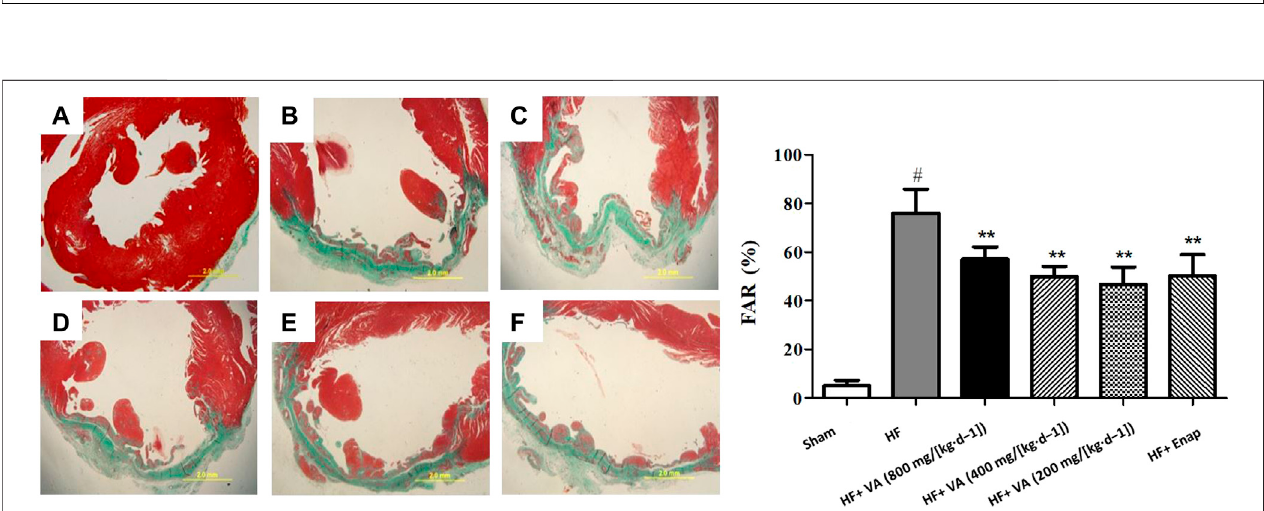
FIGURE 4| The effect of velvet antlers (VA) on myocardial collagen deposition. (A) Representative myocardialtissueof the sham group (a) , heart failure(HF) group (b) ,HF+lowdoseofVAgroup (c) ,HF+mediumdoseofVAgroup (d) ,HF+highdoseofVAgroup (e) ,andHF+enalaprilgroup (f) stainedwithMasson ’ strichrome.Bar (cid:1) 20 mm. (B) Statisticalanalysisofthe fi broticarearatio(FAR)ineachgroup.Thedataareexpressedasmeans ± SEM.#: p < 0.01vs.theshamgroup;*: p < 0.05vs.the HF group; **: p < 0.01 vs. the HF group. n (cid:1) 6.